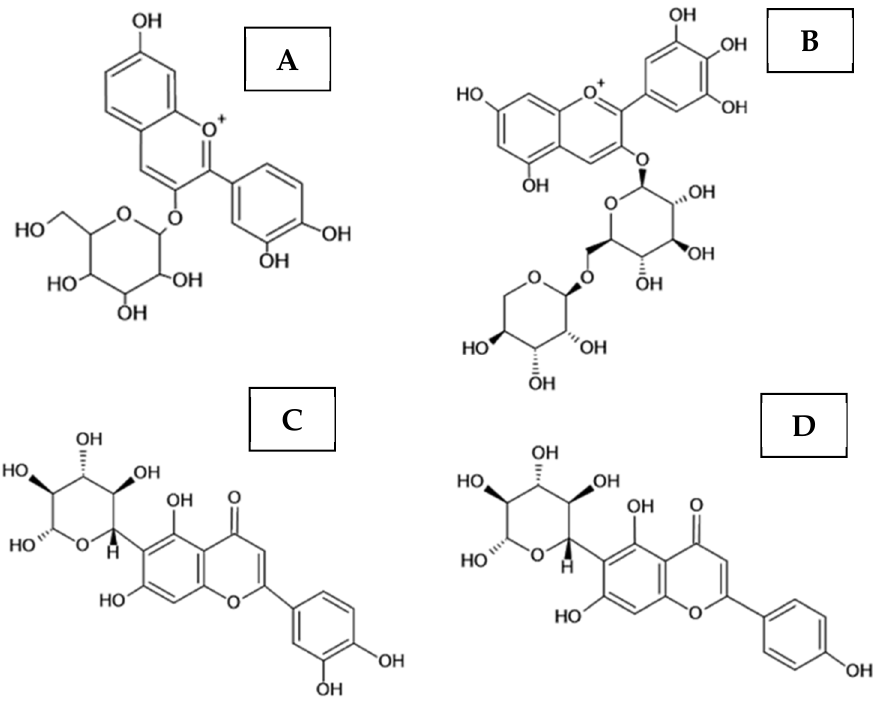
Figure 2. The structural formula of the main flavonoids identified in the açaí meal extract (Table 1). ( A ) = Cyanidin 3- O -glucoside, ( B ) = Delphinidin 3-rutinoside, ( C ) = 6-C-glycosyl luteolin (isoorientin), ( D ) = 6-C-glycosyl apigenin (isovitexin).